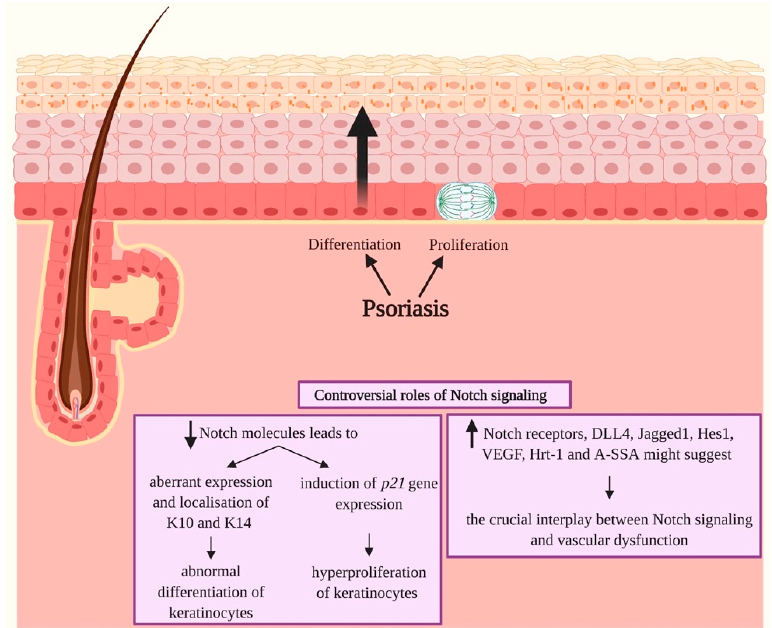
Figure 8. Psoriasis and Notch signaling. Psoriasis is defined as a chronic immune-mediated and inflammatory skin disease characterized by hyperproliferation and aberrant differentiation of epidermal cells, primary cutaneous manifestation and a strong genetic predisposition. The role of Notch signaling in Psoriasis seems to be controversial since both downregulations and upregulations of Notch molecules might be responsible for the onset of the skin disease. A decrement in Notch molecules results primarily in an abnormal differentiation of keratinocytes due to an aberrant expression and localization of keratin 10 (K10) and keratin 14 (K14) in the epidermis, and in the induction of p21 gene expression leading to hyperproliferation of keratinocytes. A hyperactivation of Notch signaling has also been registered in the skin of psoriatic patients. High expression of Notch receptors, Jagged1, hairy/enhancer of split 1 (Hes1), vascular endothelial growth factor (VEGF), Ring-box protein HRT1 (Hrt-1) and Acute-phase Serum Amyloid A (A-SSA) have been registered, and they suggest the tight link between Notch signaling and vascular dysfunction in Psoriasis. Pointed arrows ( → ) define the induction of the indicated process or associated function. The arrows facing upwards ( ↑ ) indicate an upregulation, while the arrows facing downwards ( ↓ ) designate a downregulation of Notch molecules.